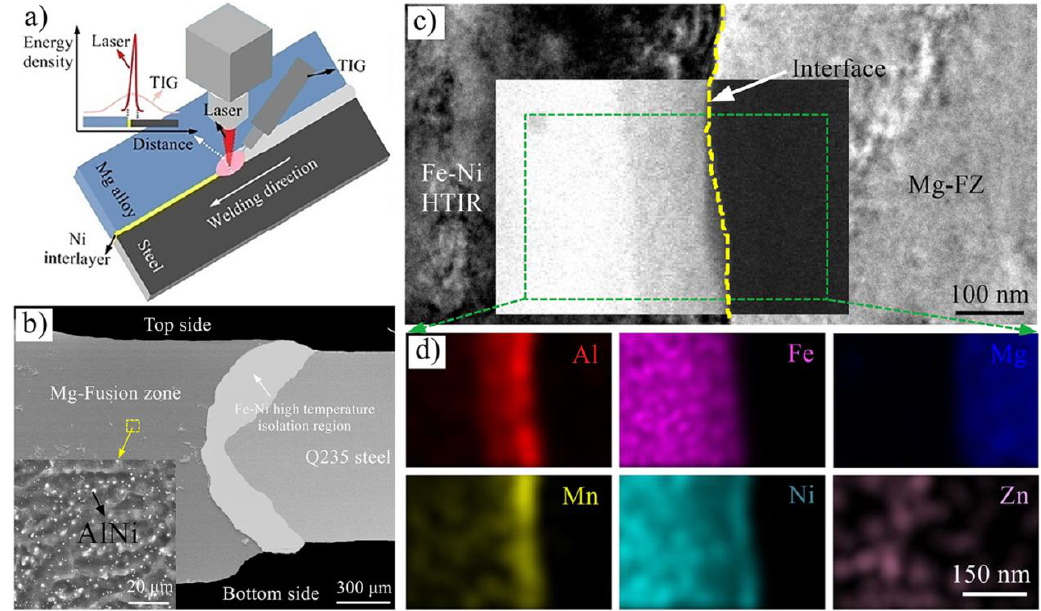
Figure 22. Laser-TIG double side welding process with Ni interlayer [81] ( a ) schematic representation of the laser-TIG process; ( b ) Cross section of joint; ( c ) TEM bright field image and HAADF-STEM image near the interface; ( d ) elemental distribution mapped with STEM near the interface marked in ( c ).